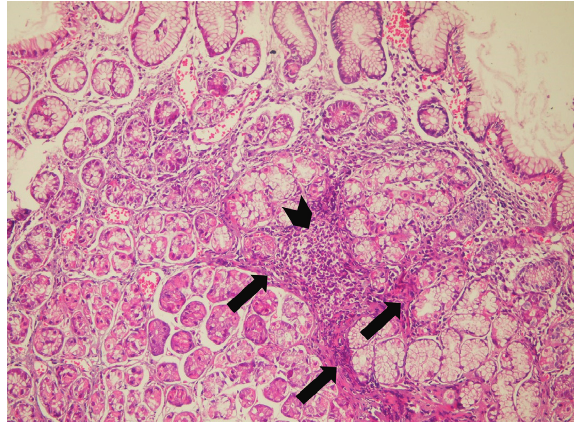
Figure 6: Photomicrograph showing chronic gastritis with mixed inflammatory cell infiltrate and lymphoid follicle formation (arrow head). There is also intramucosal fibrosis (arrows) with moderate glandular atrophy, H&E stain, × 100.